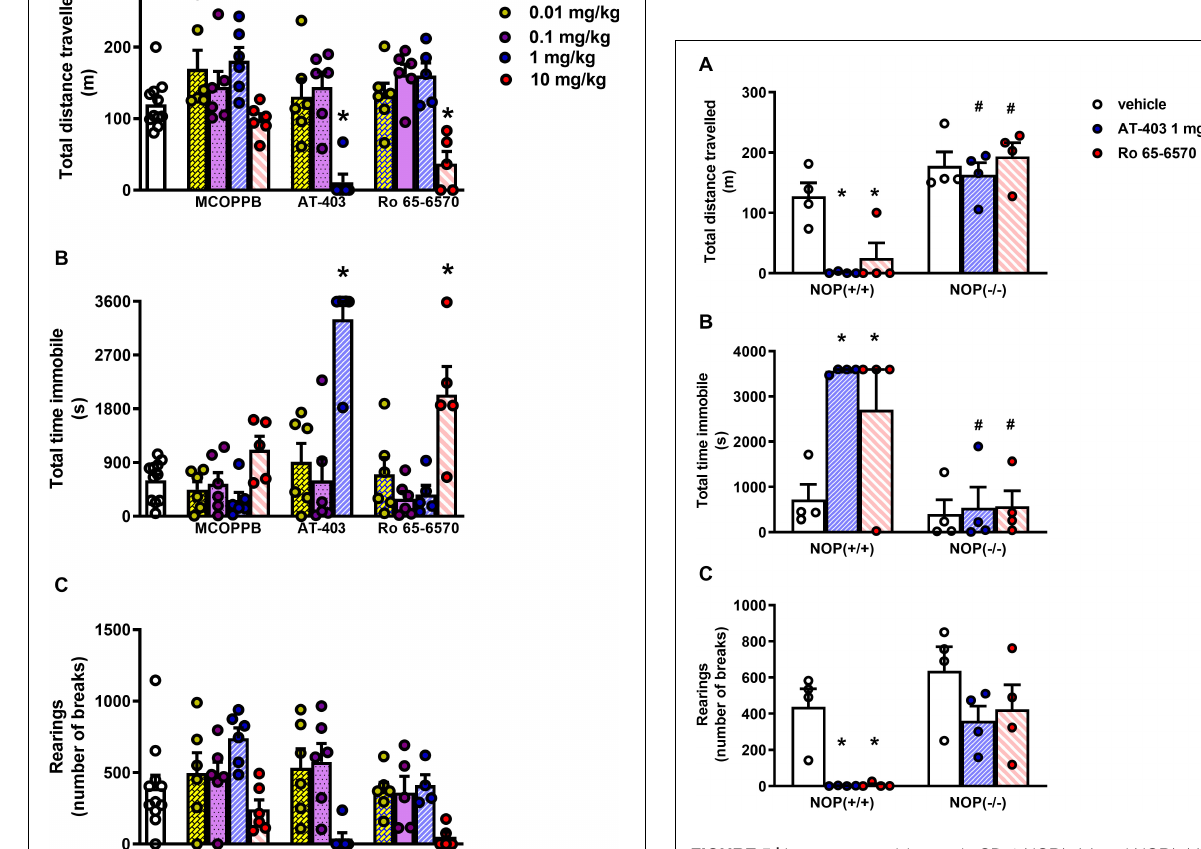
FIGURE 5 | Locomotor activity test in CD-1 NOP(+/+) and NOP(–/–) mice, effects of AT-403 and Ro-656570 injected i.p. (A) cumulative distanced traveled in 60 min, (B) total time spent immobile in 60 min, (C) cumulative number of rearings performed in 60 min. Each point represents the mean ± SEM of 5 mice/group. Two-way ANOVA treatment × genotype revealed an effect of treatment, genotype, and their interaction in the total distance traveled [ F ( 2 , 19 ) = 5.83, F ( 1 , 19 ) = 55.83, F ( 2 , 19 ) = 5.08], immobility time [ F ( 2 , 19 ) = 5.36, F ( 1 , 19 ) = 22.55, F ( 2 , 19 ) = 4.29], and of number of treatment and genotype in the number of rearings [ F ( 2 , 19 ) = 8.75, F ( 1 , 19 ) = 17.99]. * p < 0.05 vs. vehicle, # p < 0.05 vs. NOP(+/+), Tukey’s